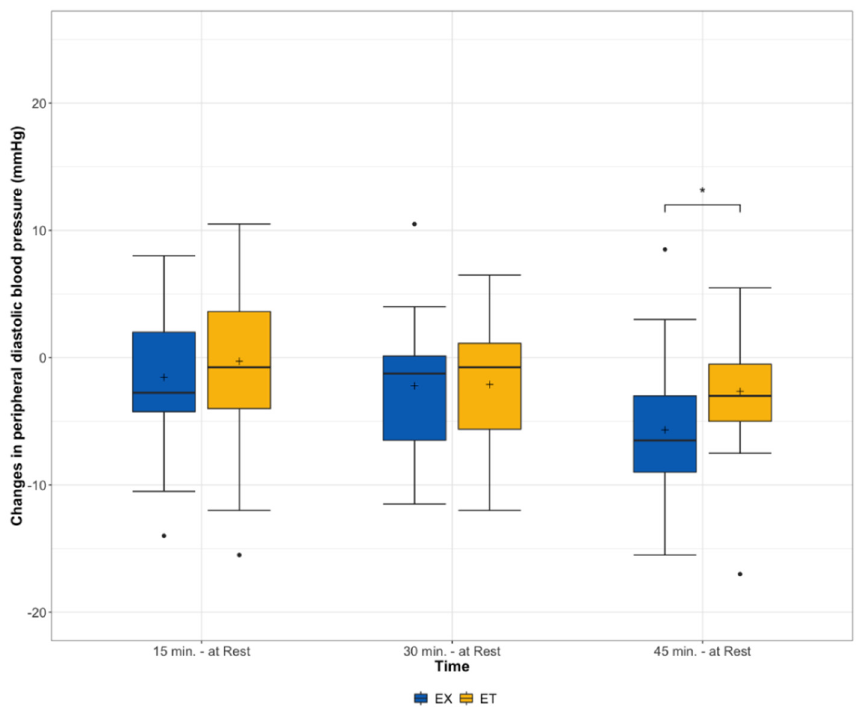
Figure 2. Changes in peripheral diastolic blood pressure from rest before and 15, 30, and 45 min after exercise stratified according to the type of exercise (ET = moderate endurance exercise, EX = exergaming session), interaction effect * = p < 0.05.